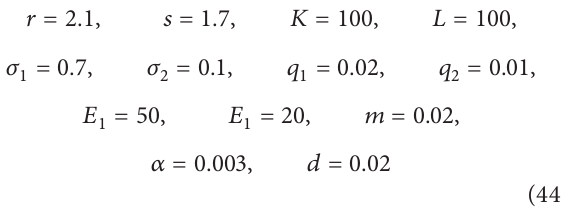
Figure 2: Plot of prey population in reserved area 𝑦 versus time 𝑡 .